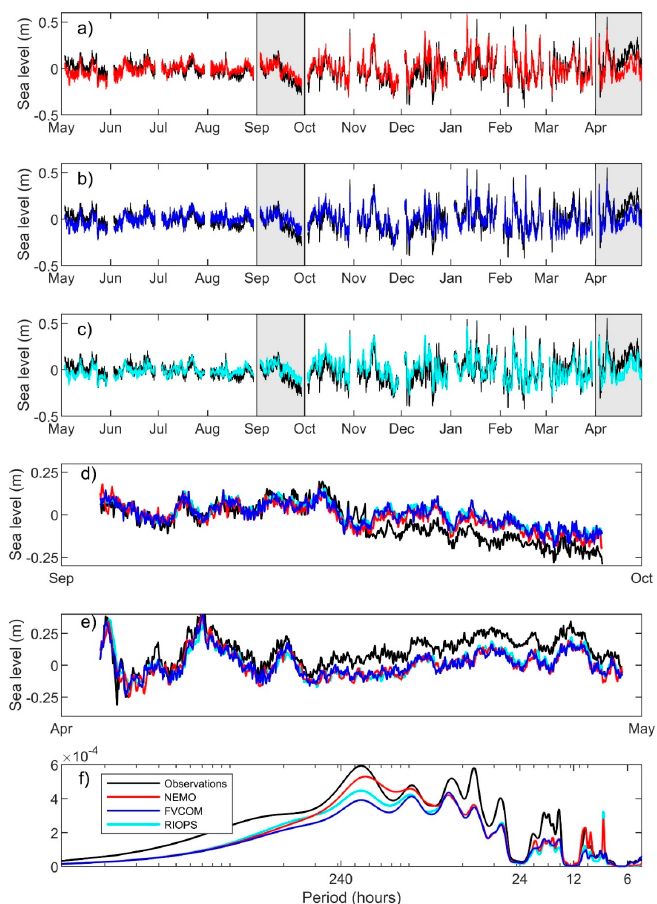
Figure 4. ( a – c ) One year time series of the residual water level at the Saint John tide gauge location from a) the NEMO, b) the FVCOM, and c) the RIOPS. Observations are shown in black in each panel. The shaded areas in a – c highlight the time frame of the Fall freshet (September 2015) and the Spring freshet (April 2016), and are expanded in d ) and e ), respectively. f ) The spectra for the time series in a – c in variance-conserving form. The legend in panel f applies to all panels. The residual water level was computed by removing the tidal component (as determined by t_tide). An additional filter was applied to remove the extra energy in the tidal period bands (22 – 28 h, 11 – 14 h, 5 – 7 h). Table 3. The evaluation metrics for the residual water level and currents (see definitions in equations 5-8 and in text), averaged for the stations in the inner and outer SJH, separately. Numbers in brackets are the standard deviations across the stations. RMSE, RAE, R and Skill are defined in equations (6) – (9). Note that for the water levels, the mean bias is not computed and the other metrics are computed for the demeaned time series. Water level metrics are computed for NEMO, FVCOM and RIOPS. Current metrics are computed for NEMO and FVCOM only.